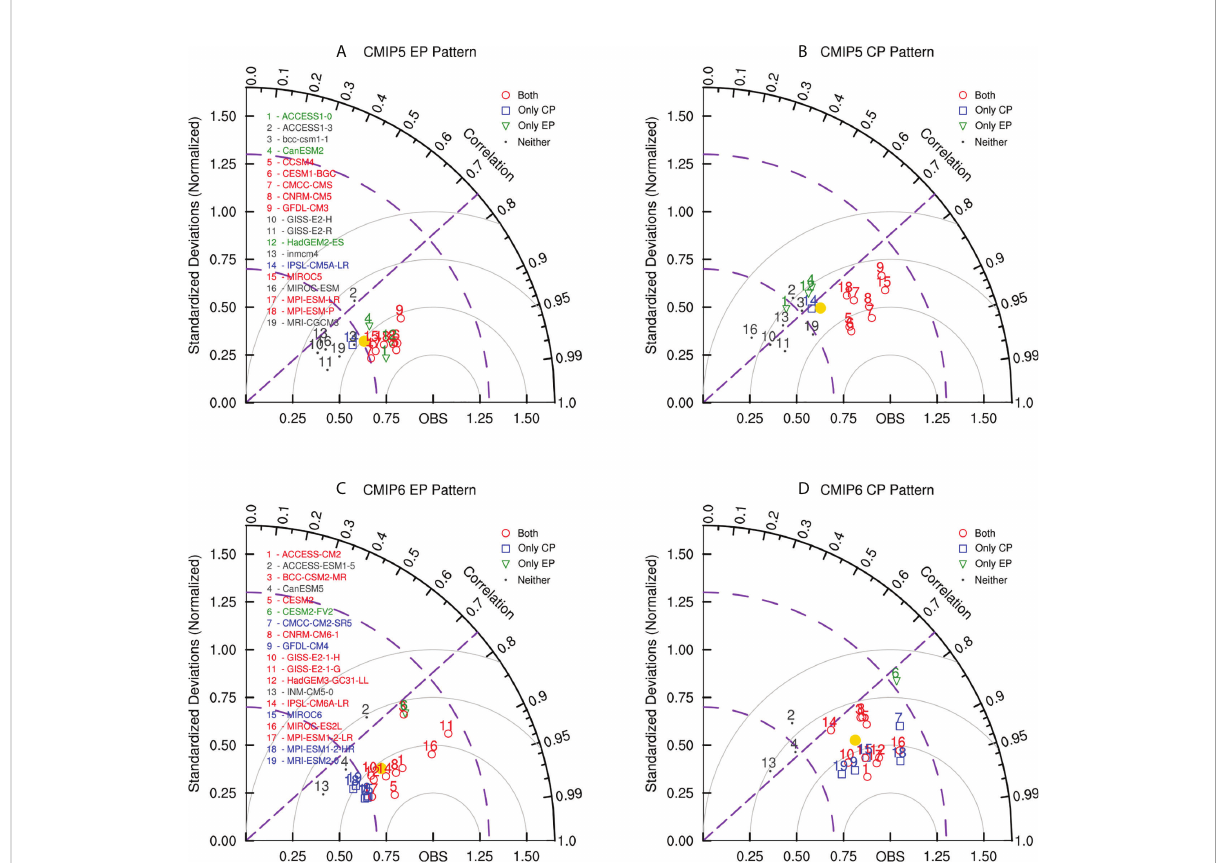
FIGURE 2 Taylor diagram displaying normalized spatial pattern statistics of EP ENSO and CP ENSO between 19 CMIP5 models (A, B) and 19 CMIP6 models (C, D) , and observations for 1980-2021. Point “ OBS ” signi fi es the observational pattern based on the HadISST dataset. The radial coordinate gives the standard deviation normalized by the observed value, and the angular coordinate shows the spatial correlation with observation. Grey circles centered at point “ OBS ” represent the location of the normalized RMSE. Purple dashed lines denote the correlation coef fi cient of 0.75 and the standard deviation of 0.7 and 1.3. Color markers are different CMIP models, except for the yellow dot representing the average value of the CMIP